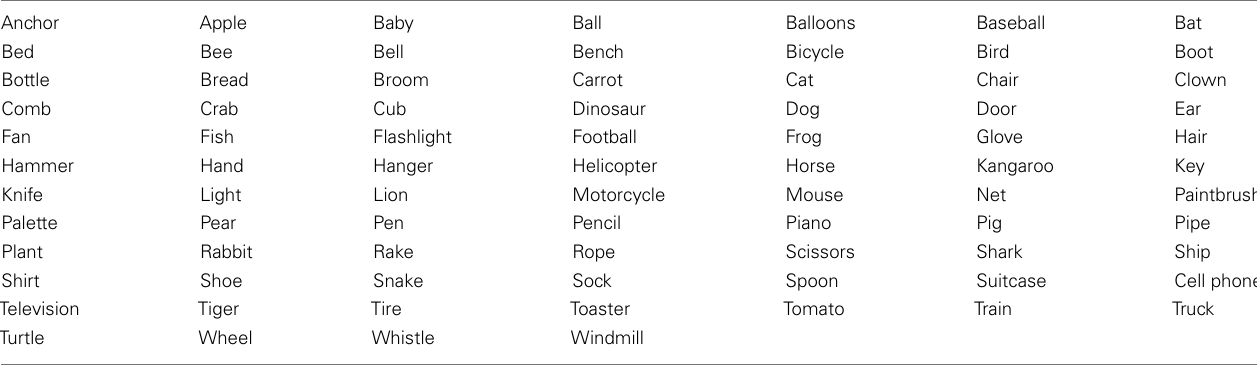
High quality color drawings were obtained for each